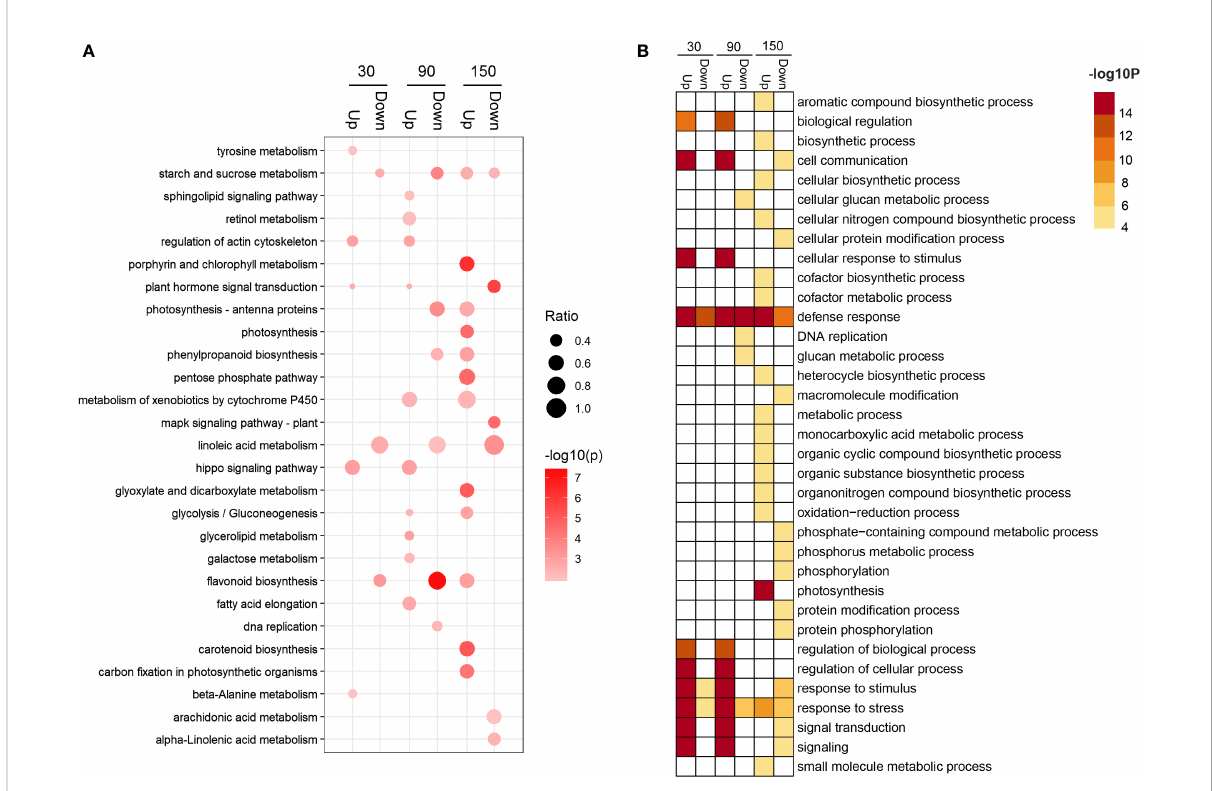
FIGURE 4 Enrichment analysis of differentially expressed genes between ‘ HanFu ’ and ‘ Huahong ’ at three stages of fruit development. (A) A bubble diagram showing the result of KEGG pathway analysis of the up- and down-regulated differentially expressed genes (DEGs). The size of the bubbles indicates the ratio of the number of DEGs in the pathway to that of the total number genes identi fi ed. (B) A heatmap showing the result of GO enrichment analysis of the up- and down-regulated